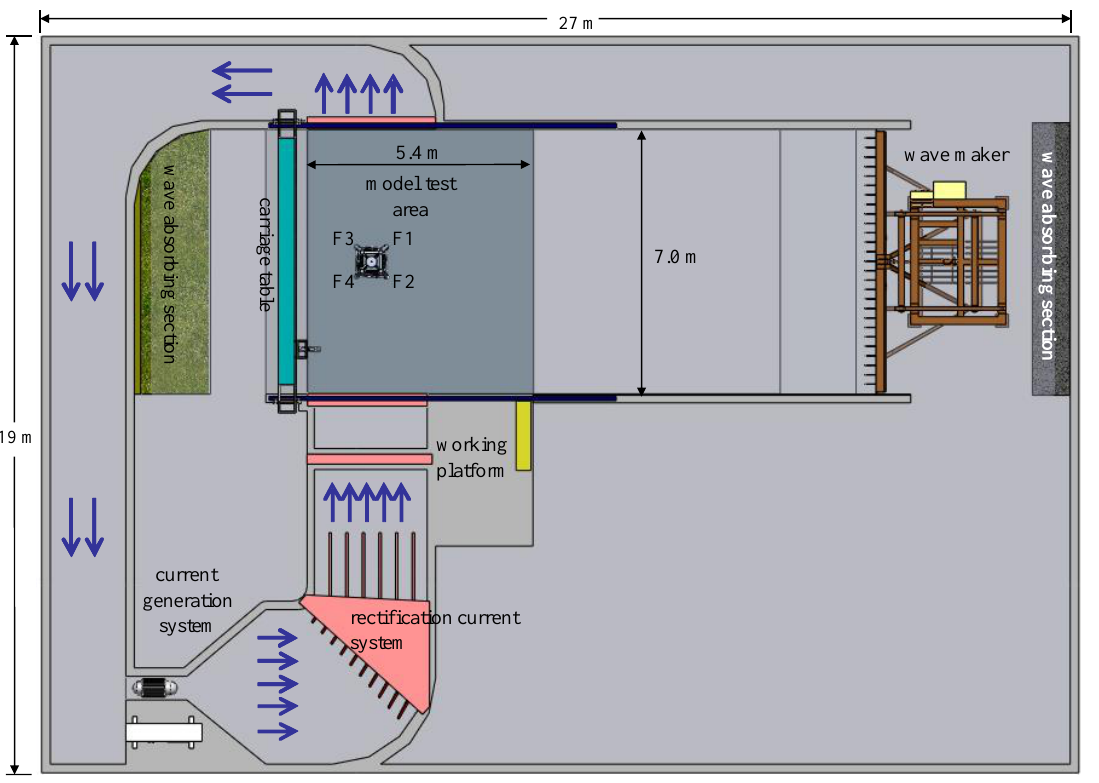
Figure 2. A sketch of the mobile bed experimental setup for scouring around the jacket-type foundation without